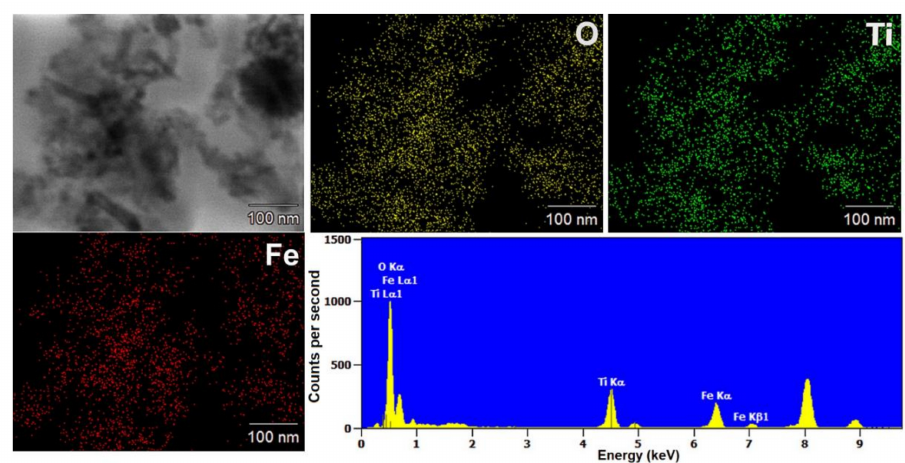
Figure 3. Results of EDS mapping for the (3)TiO 2 -(7)Fe 3 O 4